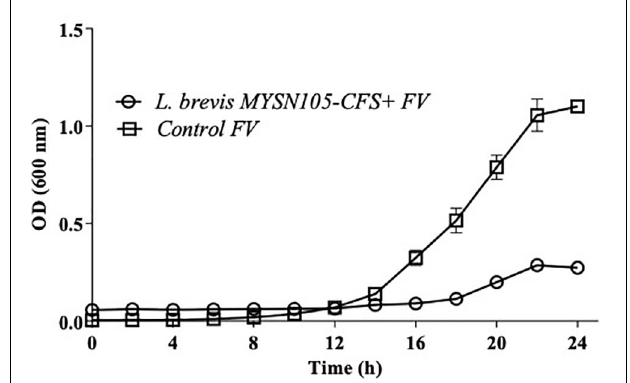
FIGURE 6 | Antifungal activity of L. brevis MYSN105 against F. verticillioides in a microtiter plate for 24 h. Data shown are mean ± SE of triplicate values of three independent experiments.